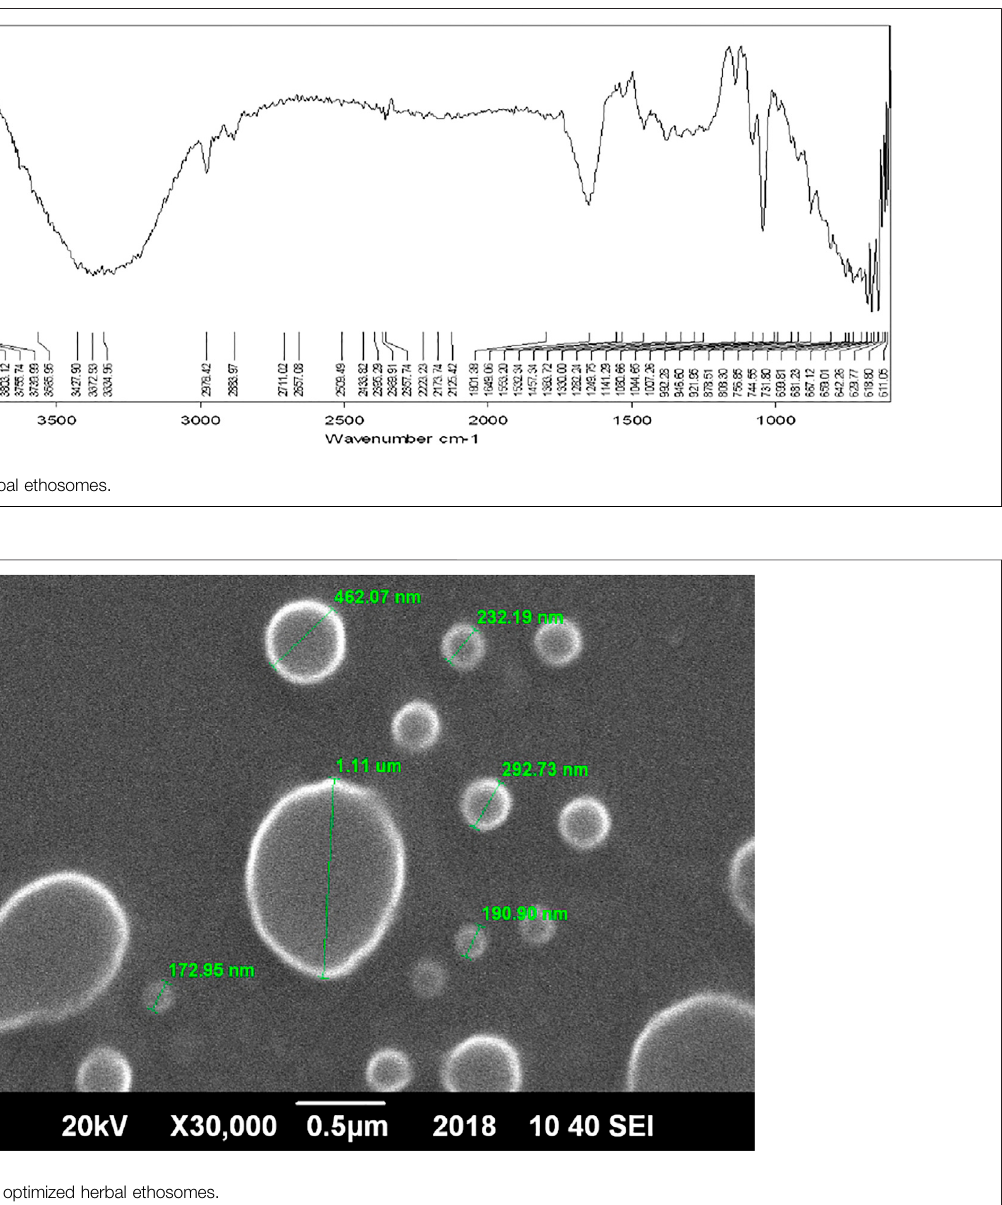
FIGURE 3 | SEM micrograph of optimized herbal